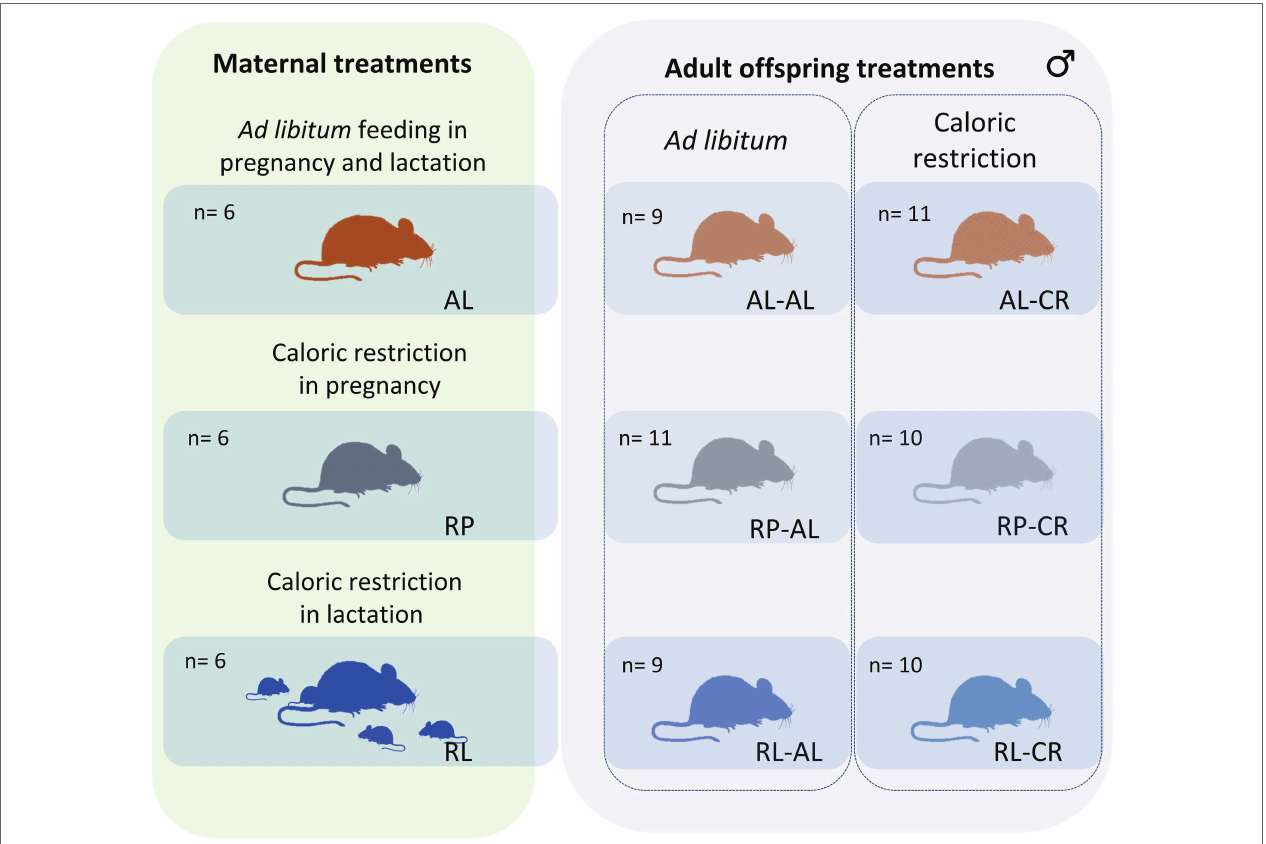
FIGURE 1 | Experimental design. We performed three maternal feeding conditions: control ( ad libitum or AL), caloric restriction in pregnancy (RP), and caloric restriction in lactation (RL). The adult male offspring of every maternal treatment were split in two groups: ad libitum access to food (AL) or twenty days of caloric restriction (CR). In the right panel, abbreviations refer to maternal condition (AL, RL, and RP) and in the left panel, additional adult treatment (AL or